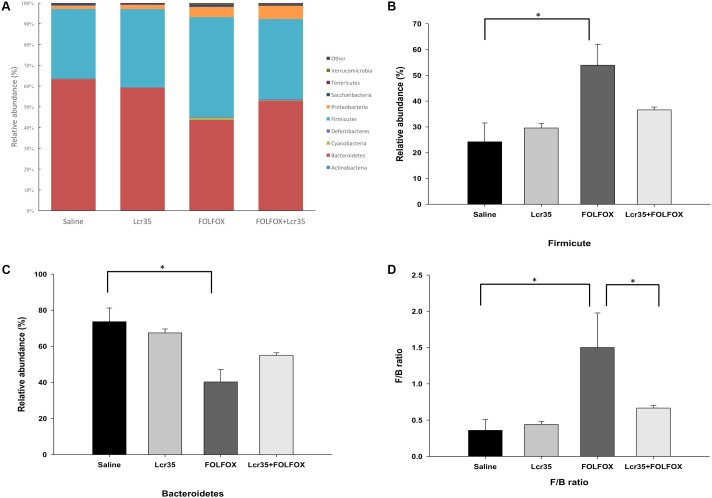
Effects of Lcr35 on changes in the gut microbiota from stool of subcutaneously injected colorectal cancer mice challenged with FOLFOX. Gut microbiota composition was determined by (A) taxonomy at phylum level, (B)
Firmicutes, (C)
Bacteroidetes, and (D)
Firmicutes-to-Bacteroidetes (F/B) ratio. The mice received saline or Lcr35 (1 × 107 CFU/daily) daily during the experiment. Values are presented as the mean ± SEM. ∗p < 0.05.